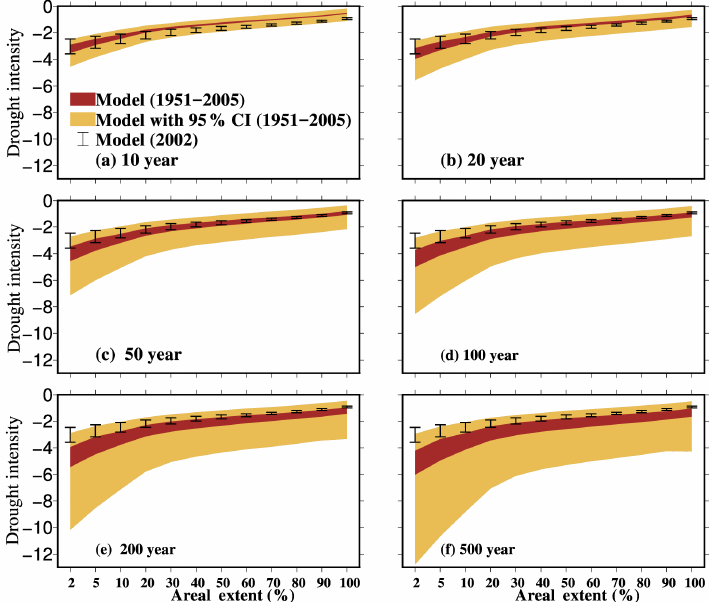
Figure 5. Uncertainty in intensity–areal extent–frequency (IAF) curves for the monsoon season 60cm soil moisture drought estimated using the three LSMs. Dark brown color shade shows uncertainty in models without considering parameter uncertainty in the Generalized Extreme Value (GEV) distribution, while light brown color shows uncertainty considering the 95% confidence interval of the GEV parameters for return periods (a) 10, (b) 20, (c) 50, (d) 100, (e) 200, and (f) 500 years. Black error bars indicate uncertainty for the 2002 monsoon season drought using three